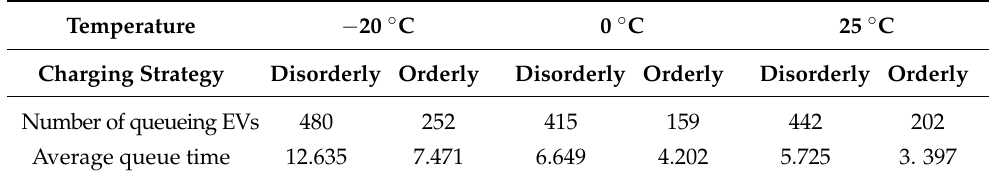
Table 2. Queueing conditions at different